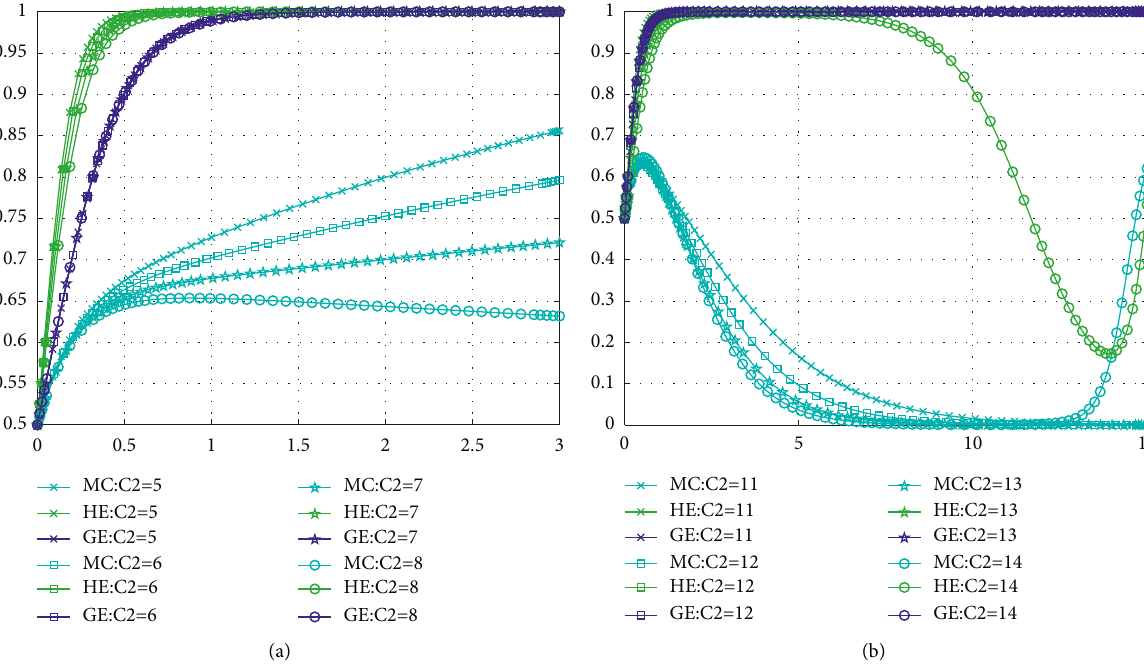
Figure 4: The evolutionary results of high-tech enterprises choosing independent innovation